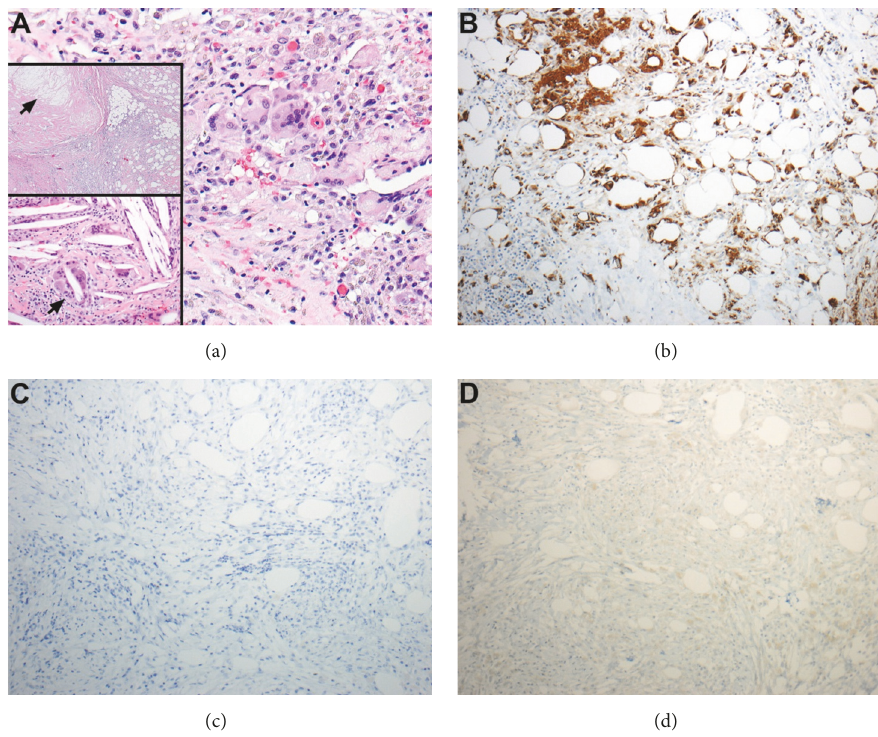
Figure 3: Pathology of lesion following partial nephrectomy. (a) Pathology of lesion showing area with prominent hemosiderin laden macrophages and multinucleate giant cells (H/E, 20X). Lower inset demonstrating foci of giant cells associated with cholesterol clefts (arrow) (H/E, 20X). Upper inset shows necrotic fat (arrow) with surrounding inflammatory reaction (H/E, 4X). (b) CD68 (KP1) immunohistochemistry (10X). CD68 is highly expressed by monocytes, macrophages, and histiocytes and is positive in numerous histiocytes and macrophages in adipose tissue. (c) Immunohistochemistry demonstrating a negative study for cytokeratin AE1/AE3 confirming no recurrence of renal cell carcinoma (10X). (d) Immunohistochemistry demonstrating a negative study for PAX-8 confirming no recurrence of renal cell carcinoma